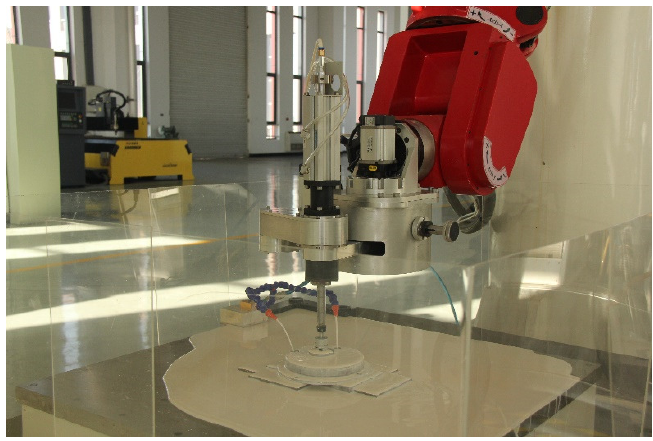
Figure 8. Polishing experiment on fused silica elements.